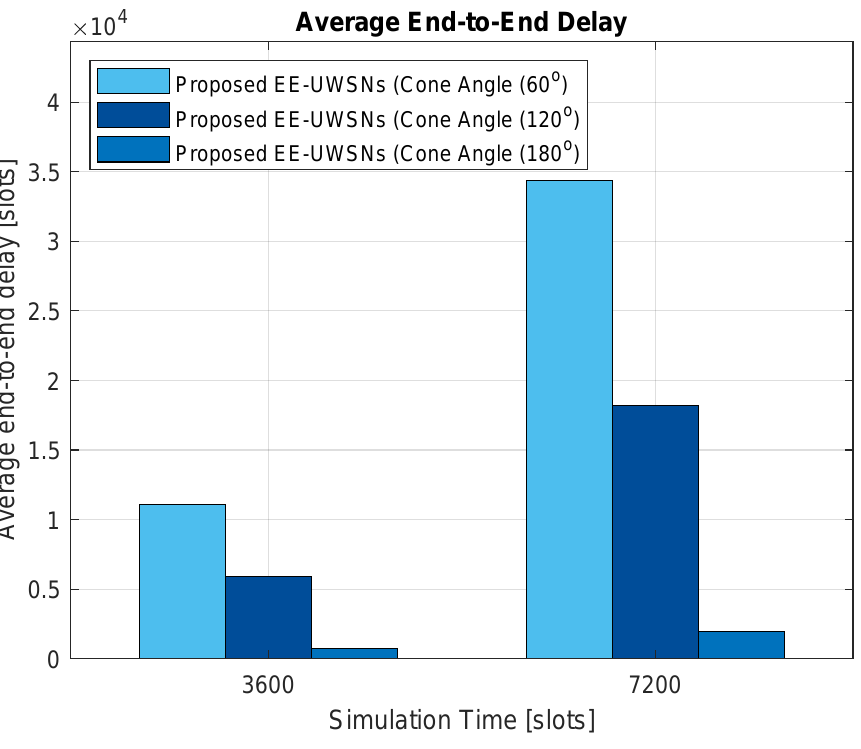
Figure 14. The effect of changing cone angle on end-to-end delay.